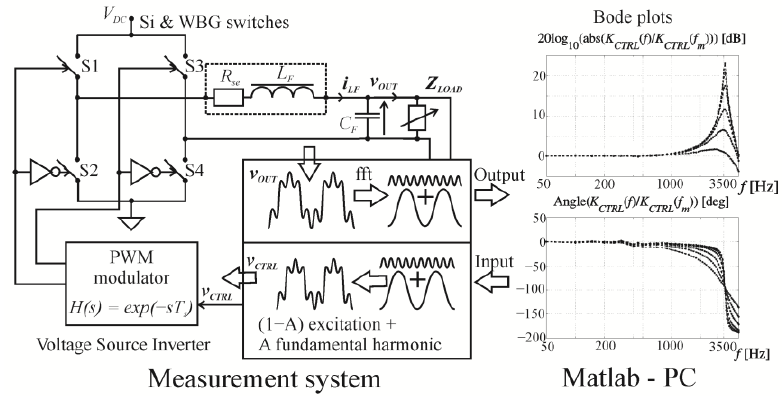
Figure 5. Measurement of VSI power conversion losses using Bode plots.